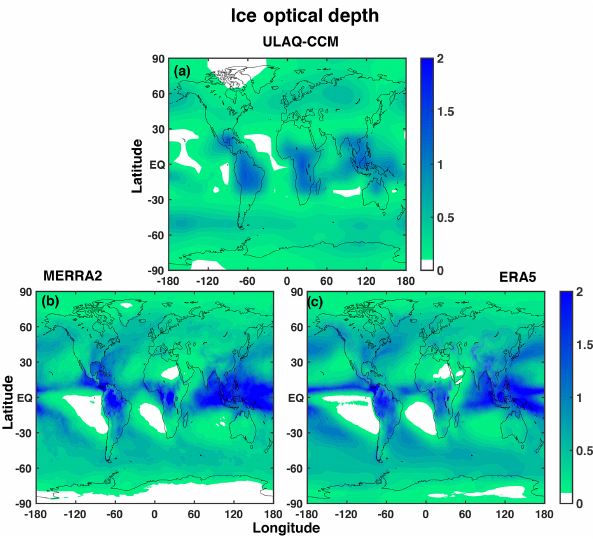
Figure 2. Ice optical depth at λ = 0 . 55µm, from ULAQ-CCM cal- culations (a) and from the MERRA-2 (b) and ERA5 (c) ice mass mixing ratio (100 < p < 450hPa), with ULAQ-CCM particle ef- fective radius. Time is averaged over the years